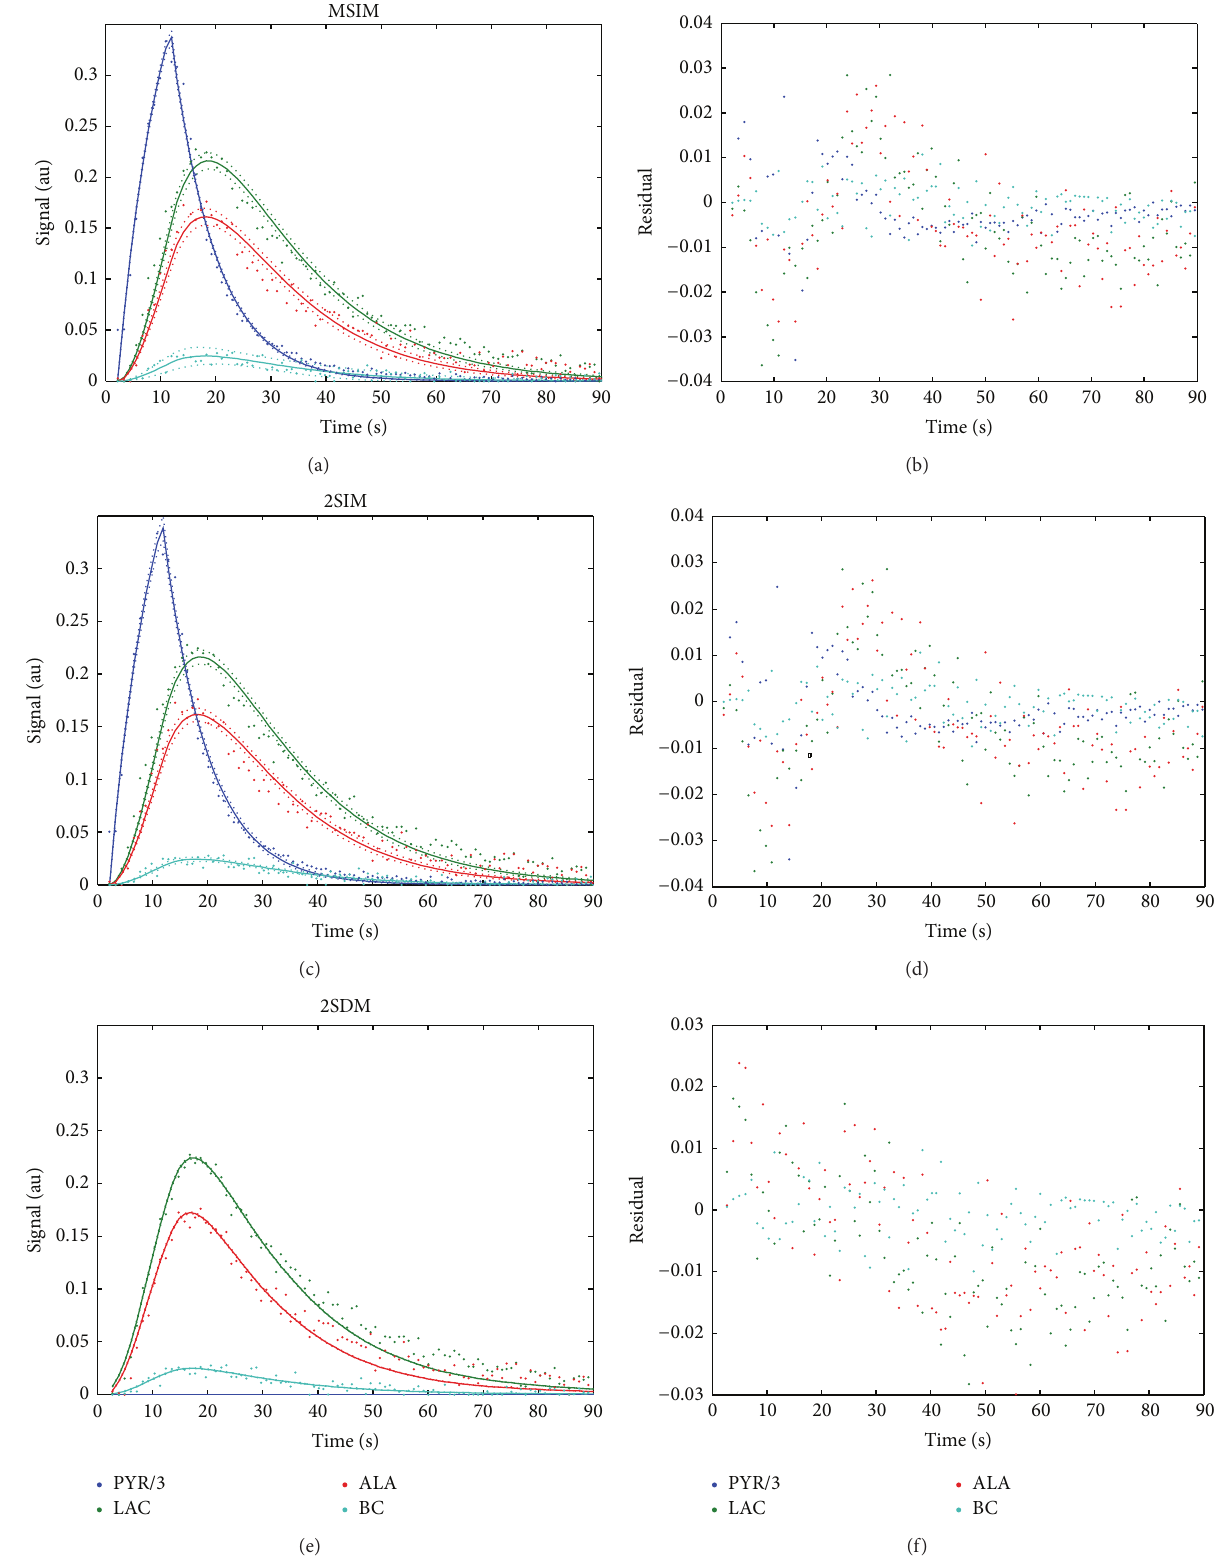
Figure 1: Example of metabolic data acquired for a 40 mM (0.2 mmol/kg) dose in kidney predominant tissue, fitted curves (solid lines) using (a) MSIM, (b) 2SIM, and (c) 2SDM and 95% confidence intervals (dotted lines). (d–f) Residuals of